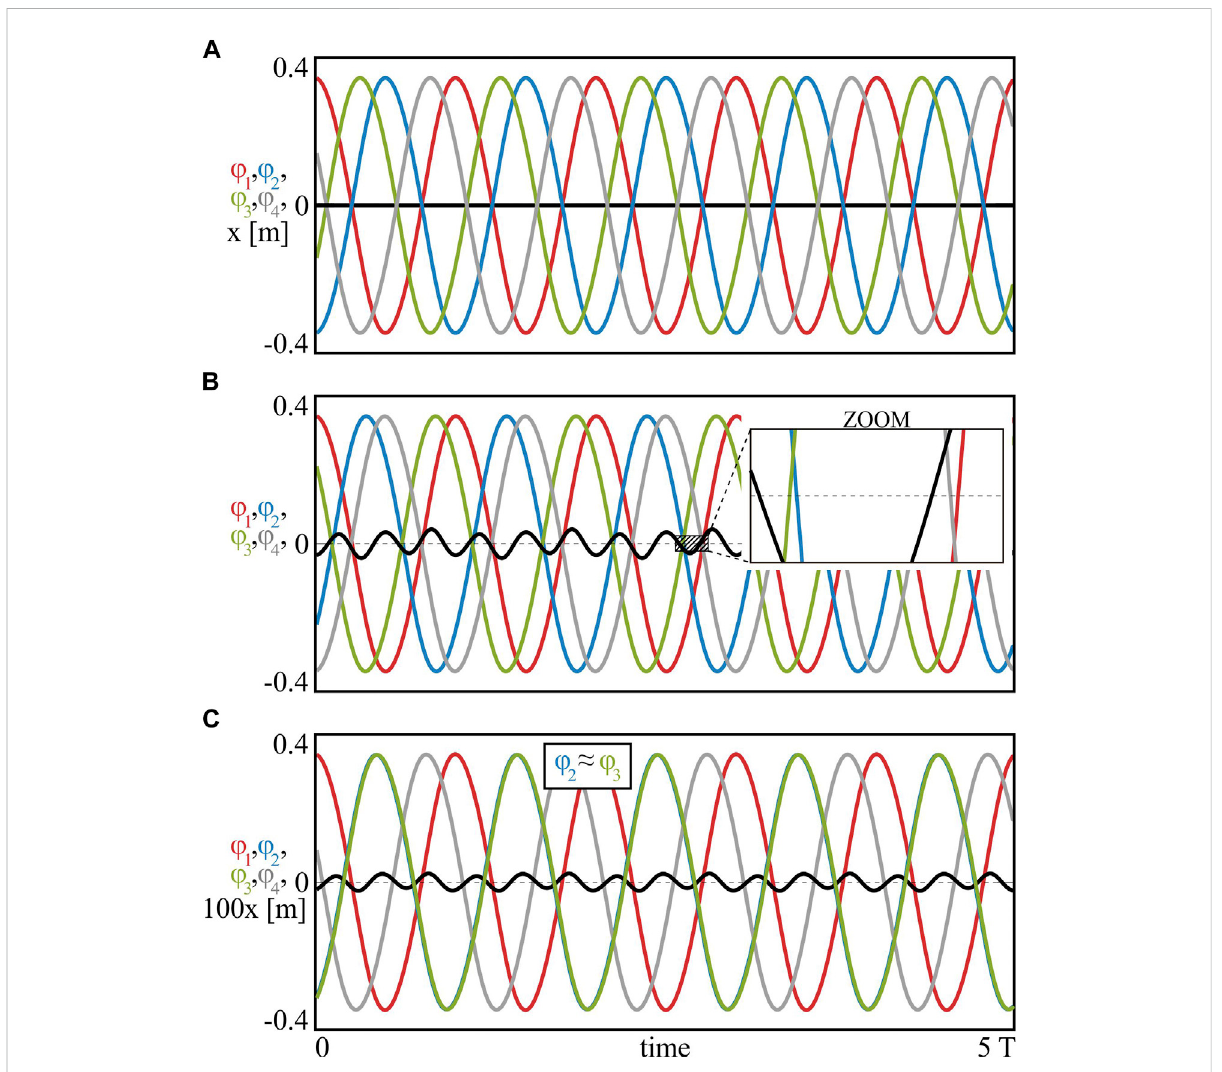
FIGURE 7 (Colouronline).Possiblebehavioursofthependulafor (A) m 1 = m 2 = m 3 = m 4 =1.0[kg](identicalmassesandthetravelingphasestate), (B) m 1 = 1.0, m 2 = 0.99, m 3 = 1.01, m 4 = 0.985 [kg] (slightly different masses and the phase – locked state) and (C) m 1 = 1.0, m 2 = 0.7, m 3 = 0.5, m 4 = 0.45 [kg] (different masses and the clustering of the pendula). System (1) with n = 4 nodes. In the case of four coupled pendula, one can identify new types of states and even more complex synchronous